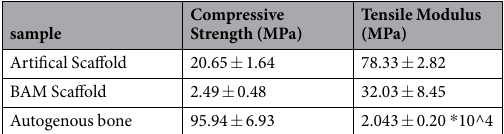
Table 1. Mechanical properties of 3D printed scaffolds.